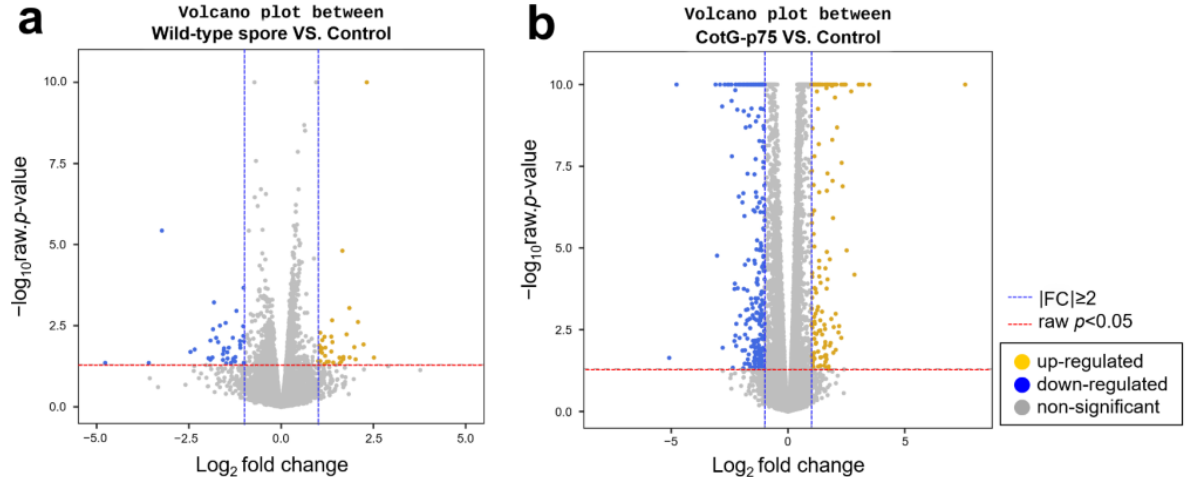
Figure 1. Differentially expressed gene (DEG) distribution trends in HT-29 cells in two comparison groups: wild-type spore-stimulated cells versus control cells ( a ), and CotG-p75-stimulated cells versus control cells ( b ). Blue vertical dashed lines indicate |Log2 (fold change)| = 1. Red horizontal dashed lines indicate the preset statistical threshold corresponding to an adjusted p -value < 0.05. Yellow and blue dots represent up-regulated and down-regulated DEGs, respectively. Gray dots represent non-differentially expressed genes.